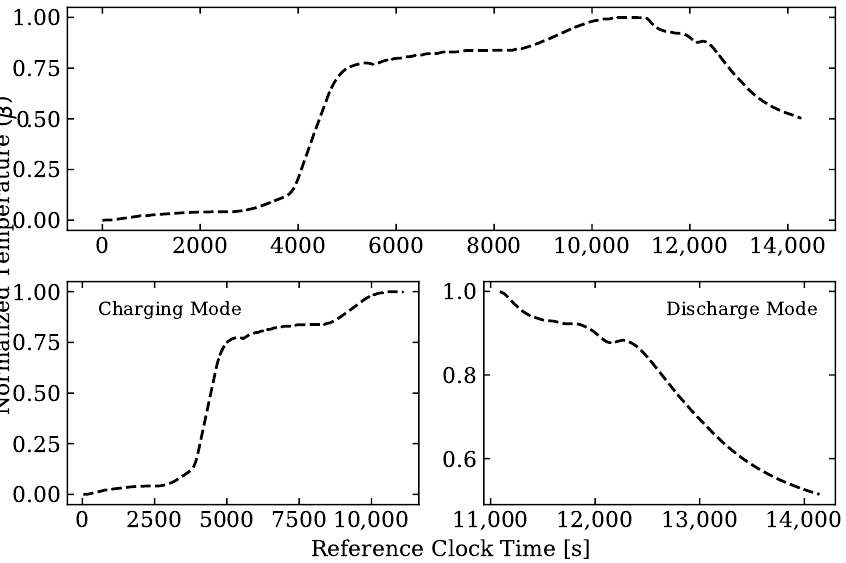
Figure 3. Normalized temperature data from the thermocline centerline location: reference value, T o = 418 ◦